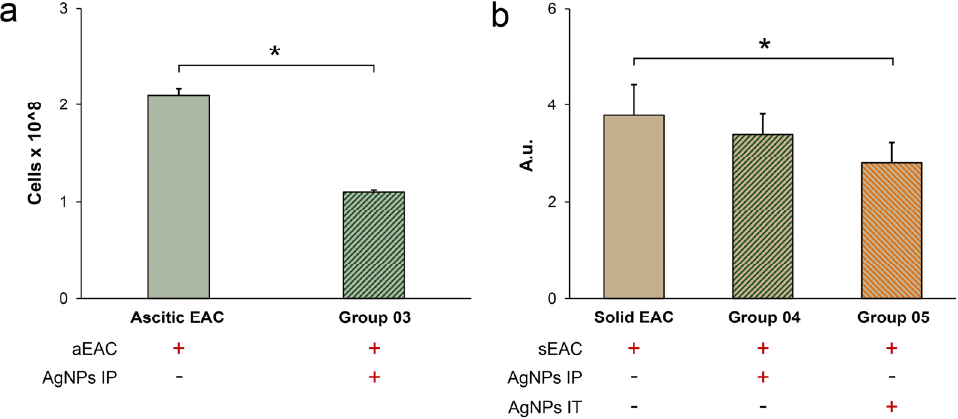
Figure 6. AgNP treatment suppress a growth of ascitic EAC ( a ) and solid EAC ( b ). Y − axis: ( a ) Cell count; ( b ) Relative units. The numbering of animal groups corresponds to the scheme in Figure 4. *: p < 0.05.